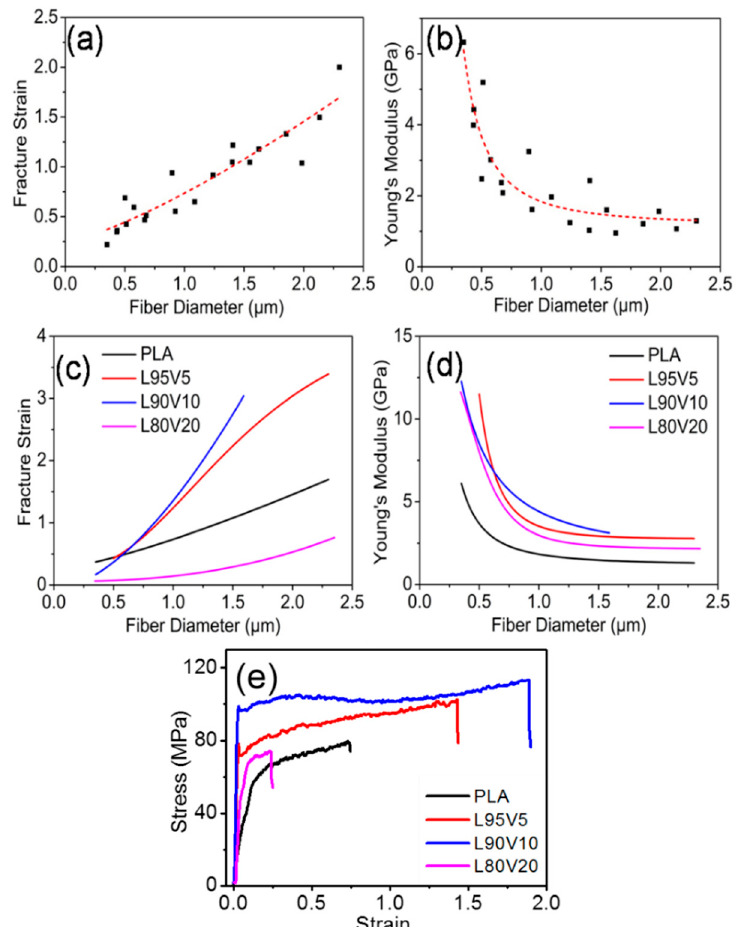
Figure 7. ( a ) Fracture strain and ( b ) Young’s modulus of pure PLA nanofibers with different diameters; ( c ) fracture strain and ( d ) Young’s modulus versus diameter for composite fibers with different PVA content; ( e ) engineering stress–strain curves for single fibers with a diameter of 1 μ m.